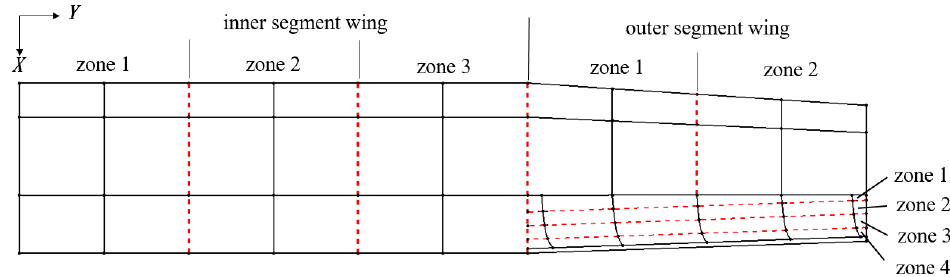
Figure 13. Top view of internal wing structure arrangement.